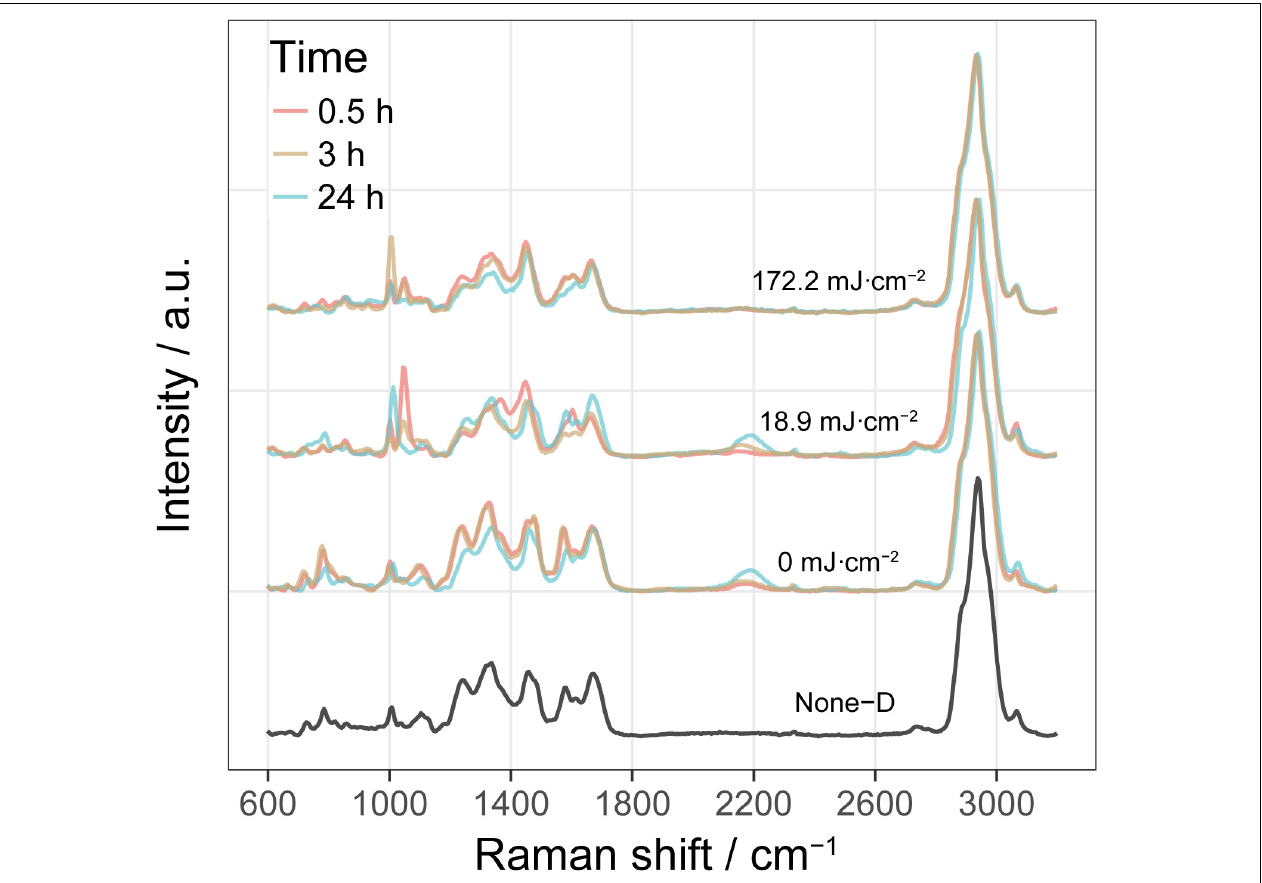
FIGURE 5 | Single-cell Raman spectra of E. coli in simulated reclaimed water (SRW) after incubation with D 2 O-amended medium for 0.5, 3, and 24 h pre-treated by UVC dose of 0, 18.9, and 172.2 mJ cm − 2 . Spectrum labeled as None-D is from E. coli grown in D 2 O-free medium. Each Raman spectrum shown here is an average of around 60 spectra from single cell with 20 from each of the three biological replicates of